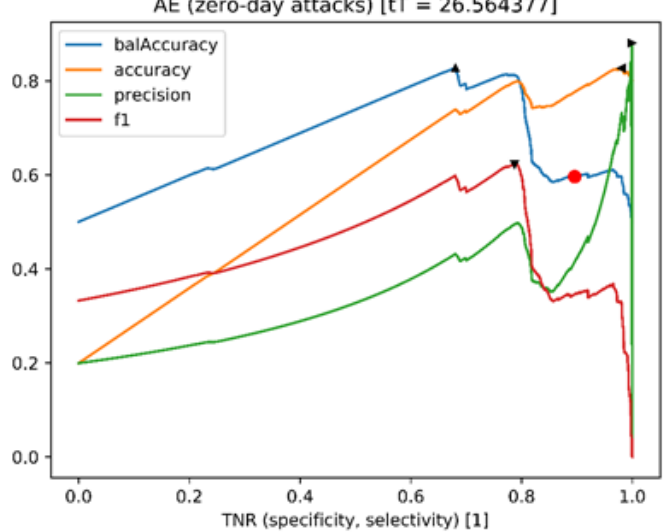
Figure 8. Optimised threshold values for zero-day